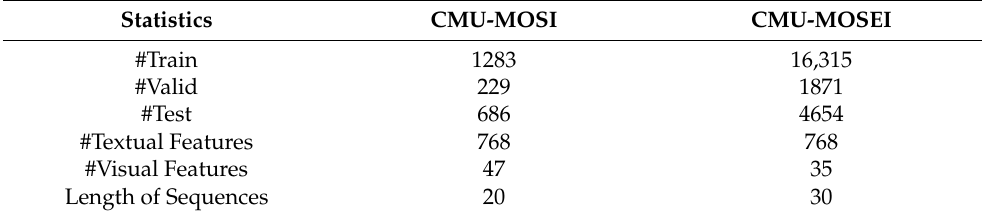
Table 4. Statistics of CMU-MOSI and CMU-MOSEI.